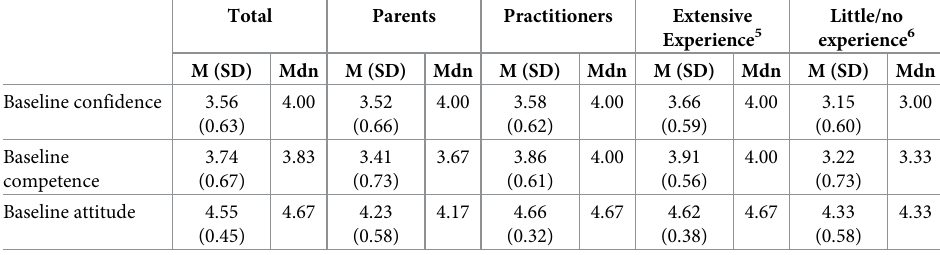
Table 2. Descriptive statistics of baseline measures from all participants (N = 93).